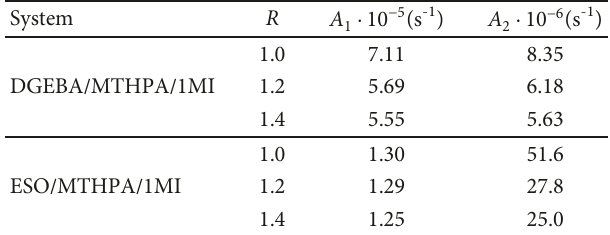
), measured on the basis r